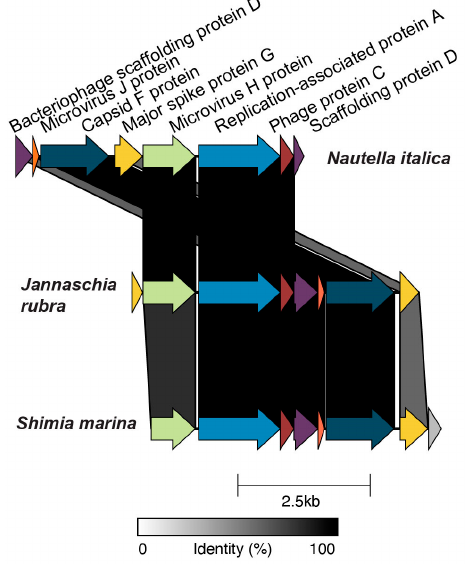
Figure 2. Microviridae prophages with a broad host range. The circular genomes are represented linearly, with the direction of the arrow representing the direction of transcription. Bacterial species names next to each prophage genome indicate the prophage hosts: Nautella italica, Jannaschia rubra, and Shimia marina. Alignment colors represent amino acid sequence identity (lower values for the microvirus H protein and the scaffolding protein D are due to differences in start and end positions in the original contigs identified through VIBRANT). Genome maps were plotted using Clinker [74].